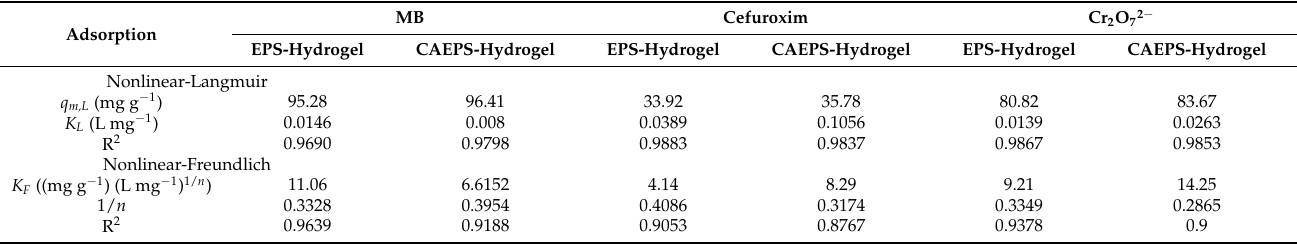
Table 1. Adsorption isotherm